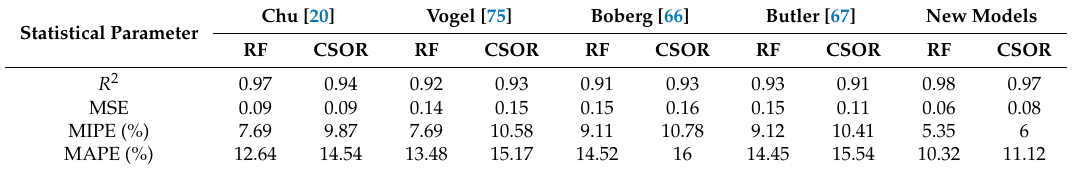
Table 8. Performances of previous predictive models and statistical correlations obtained in the current study. Statistical